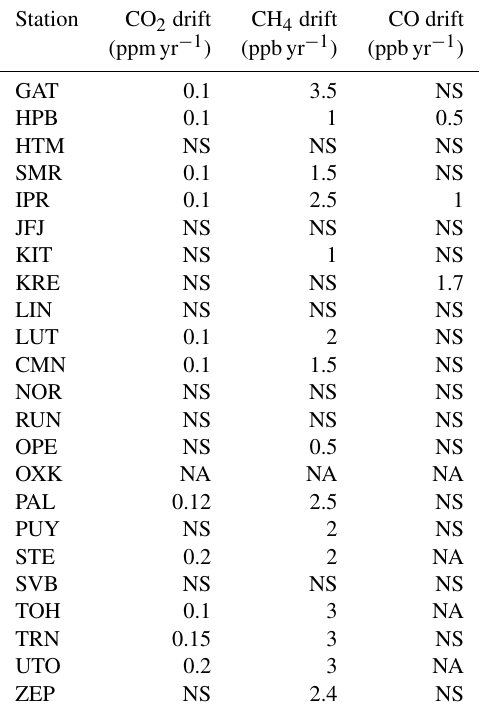
Table 5. Instrumental drift calculated as the difference between the first and last data points divided by the number of years. NS: not significant. NA: not applicable, i.e., species not measured or not enough data to estimate a trend. In the case of CO CRDS, the cali- bration usually shows variability but no drift.